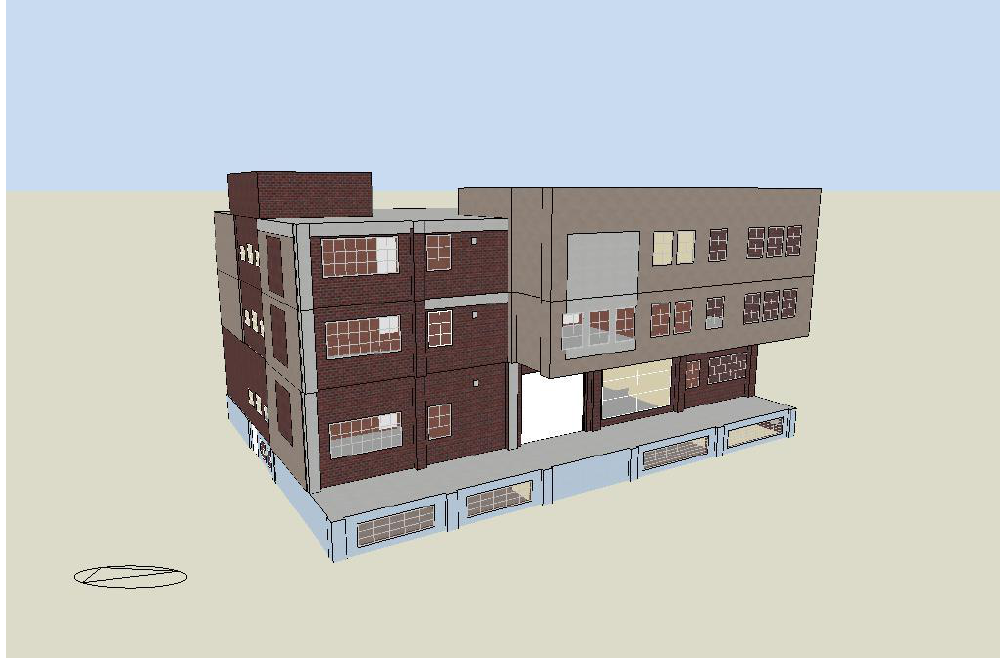
Figure 8. Axonometric projection of the building model.